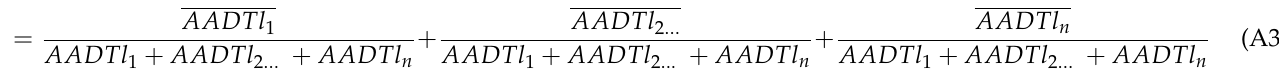
Model 5: Weighted population density per municipality, where Pm = total population, pm = population in local index.